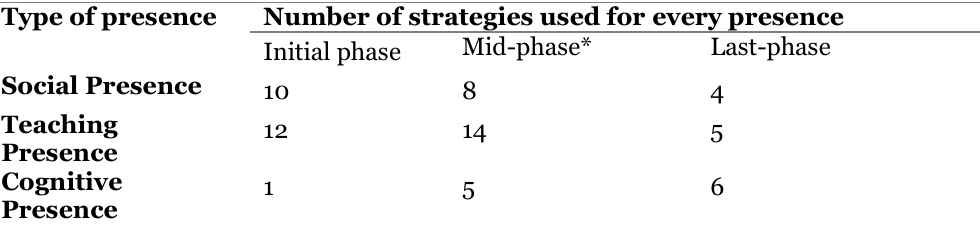
Average Number of Scaffolding Strategies Used in Different Phases Type of